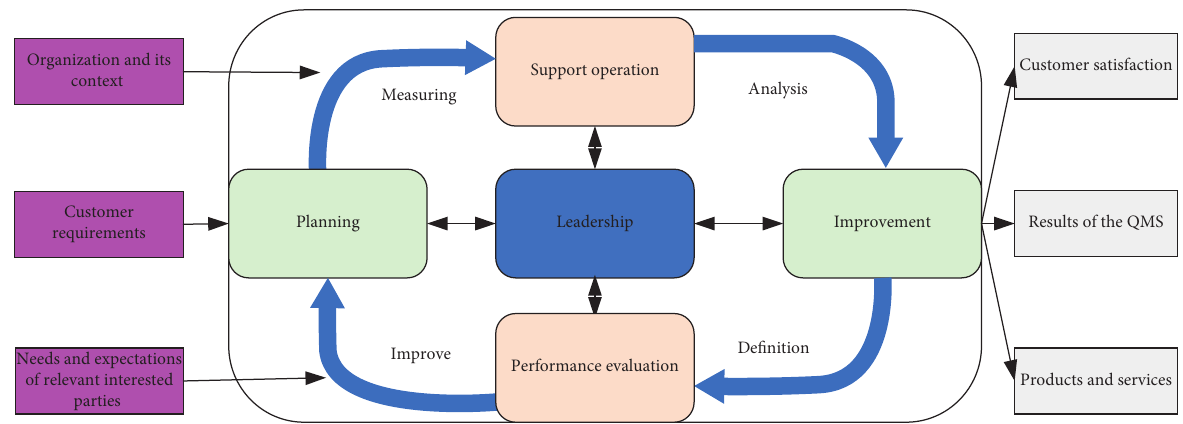
Figure 2: Flow chart of data quality management, assessment, and